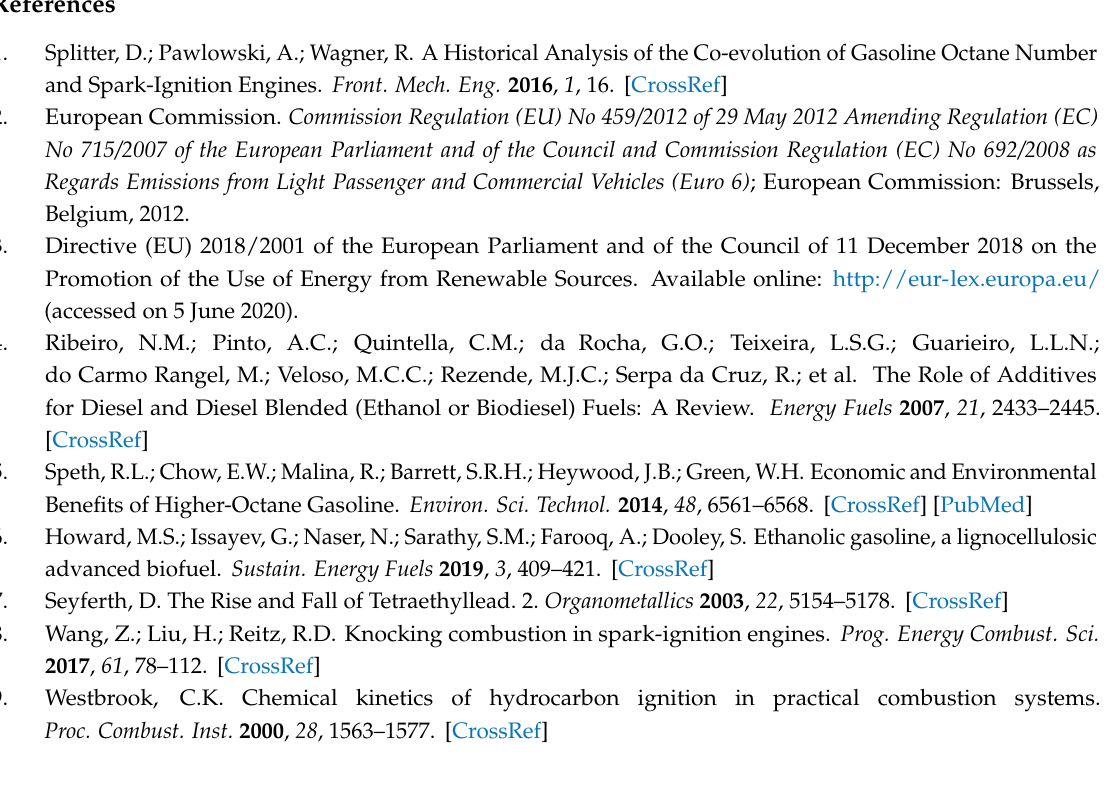
Supplementary Materials: The following are available online at http://www.mdpi.com/1996-1073/13/18/4923/ s1, Table S1: Formulation of the fuel samples used to measure DCN, containing phenols P1-P12, Table S2: Thermodynamic and kinetic data for the additives studied, Table S3: Calculation of G Tot . Average G radical was calculated as a weighted average of the O and C-centered radicals based on the radical populations. Figure S1: title, Correlation of BDE to rate constant for hydrogen atom abstraction at 800